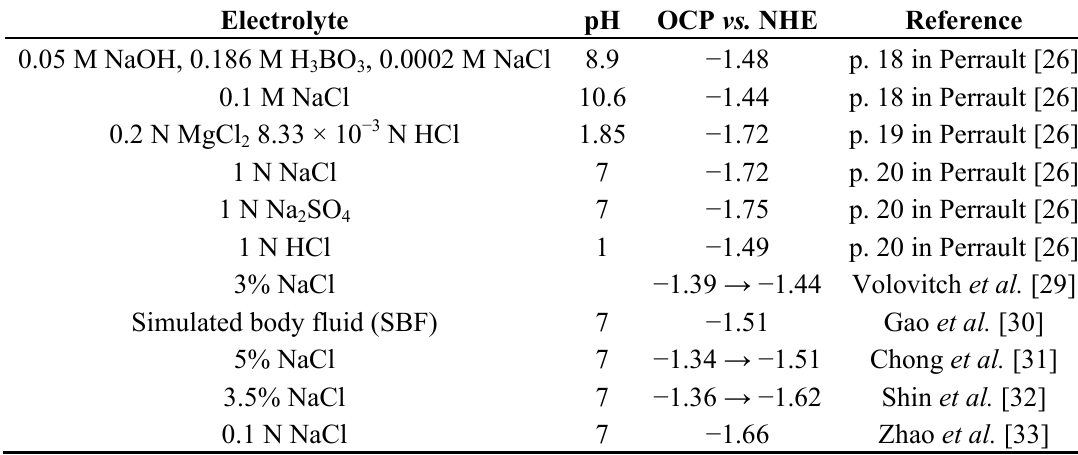
Table 3. Mg in various electrolytes.